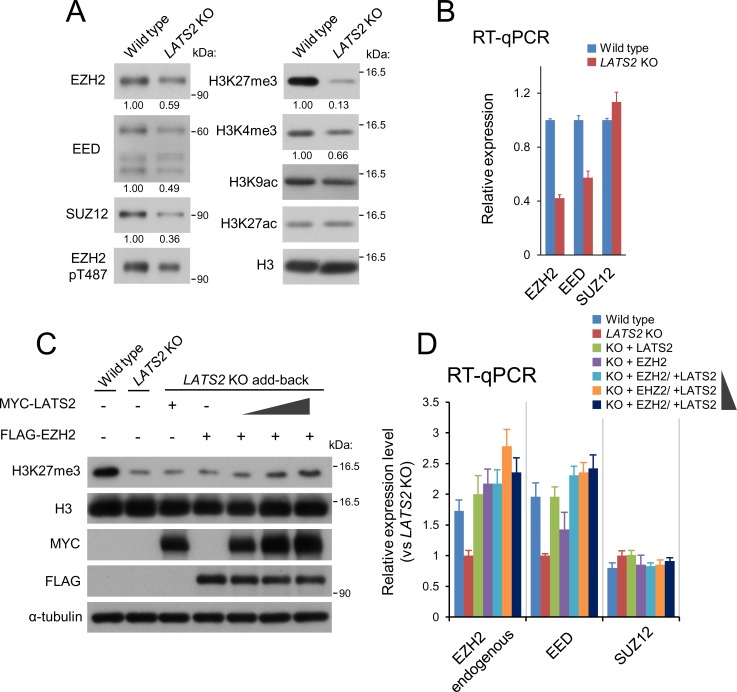
LATS2 KO downregulates PRC2 at both the protein and mRNA levels.(A) Polycomb components and major histone marks following LATS2 KO. The chromatin-bound fraction was subjected to western blotting. (B) Gene expression analysis for the core components of PRC2: EZH2, EED, and SUZ12. RT-qPCR was performed in two independent experiments, and transcript levels were normalized against ACTB; Error bars show SD. (D) Western blotting of rescued LATS2 KO cells by transient overexpression of MYC-tagged LATS2 and/or FLAG-tagged EZH2. The synergetic effects and the dose dependency of LATS2 were evaluated by increasing amounts of LATS2. (E) Gene expression analysis for the core components of PRC2 in the same setup in (D). The expression level of endogenous EZH2 was quantified by using primers targeted 3’UTR region of mRNA. RT-qPCR was performed in two independent experiments, and transcript levels were normalized against ACTB; Error bars show SD.